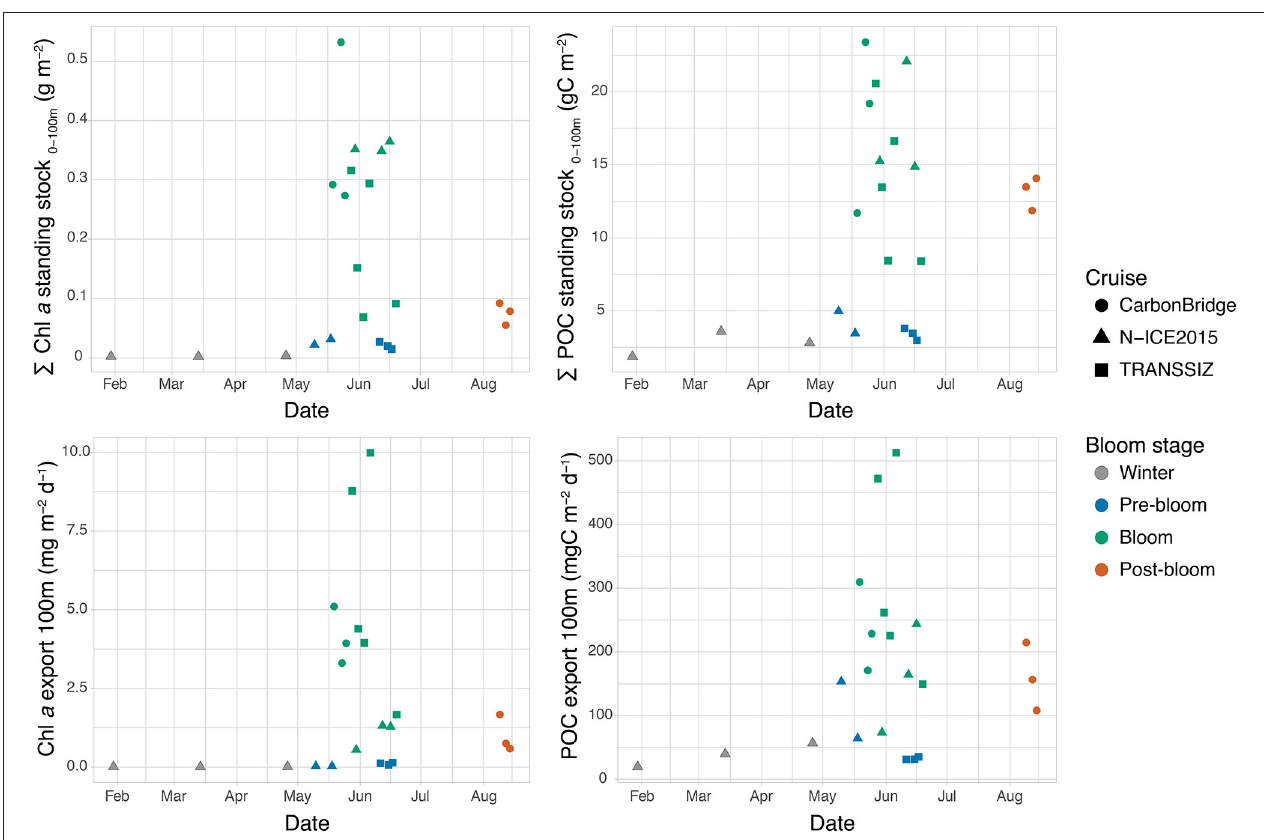
FIGURE 4 | Seasonal development of depth-integrated Chl a and POC standing stock and vertical export flux of Chl a and POC. Note that for CarbonBridge, the dates are from 2014, while for N-ICE2015 and TRANSSIZ, the dates are from 2015.